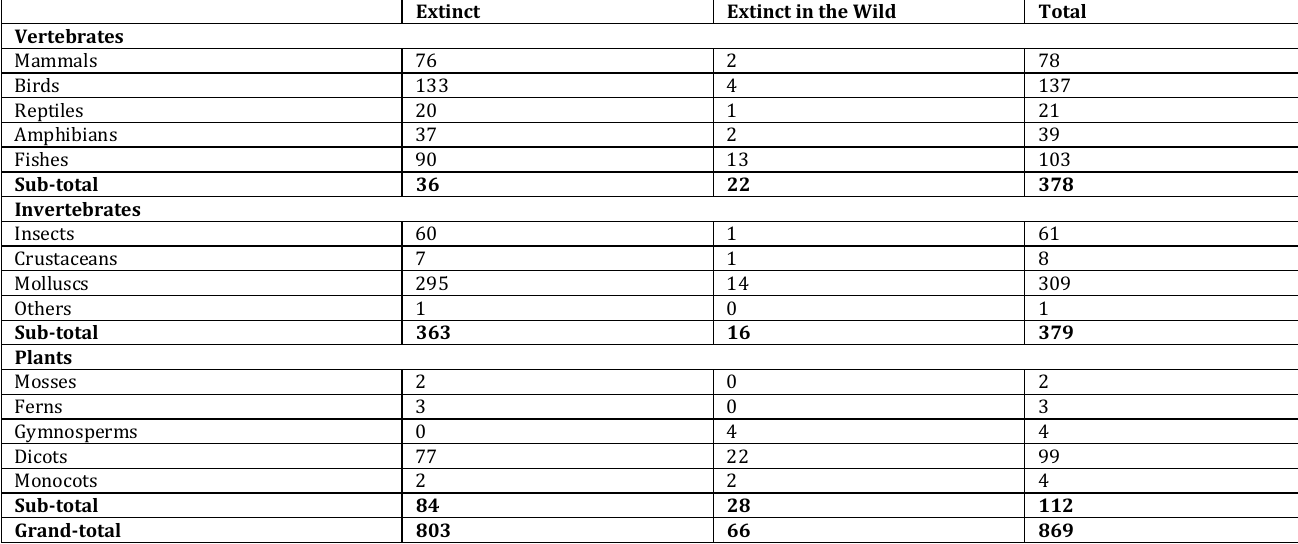
Table 2: Species of Plants and Animals that are Extinct or Extinct in the Wild